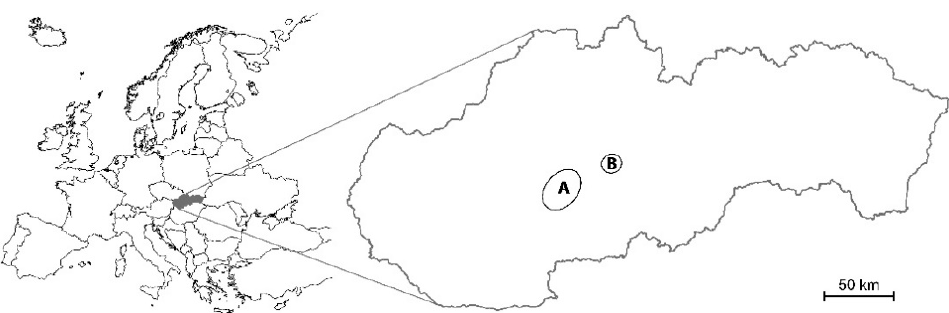
Figure 1. Map showing location of the studied areas. ( A ) Štiavnické vrchy Mts.; ( B ) Po ľ ana Mts.